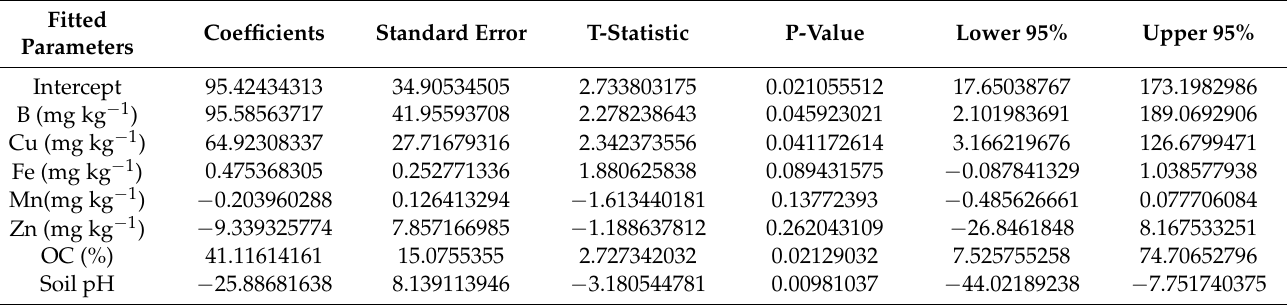
Table 3. Multiple linear regression analysis of nicotine as a response parameter and the measured micronutrients in soil. Fitted